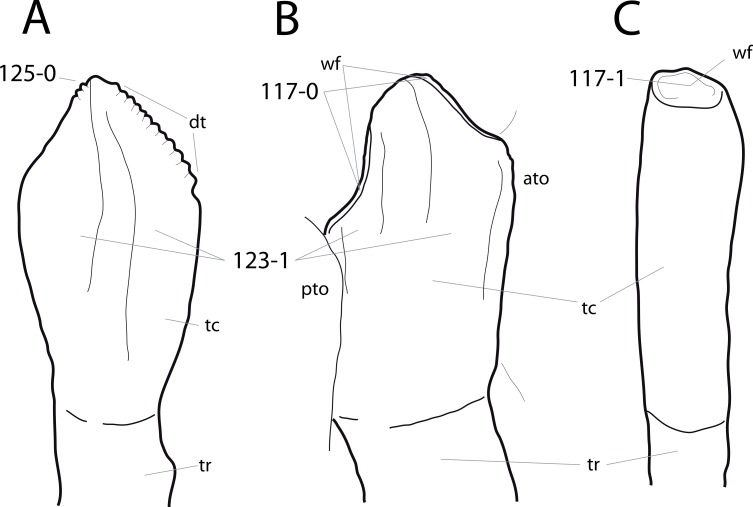
Eusauropod teeth.Tooth of Omeisaurus tianfuensis ZDM T5705 (A; traced from He, Li & Cai, 1988), Camarasaurus sp. SMA 0002 (B), and Diplodocinae indet. CM 3452 (C) in lingual view. Note the V-shaped wear facets in Camarasaurus (B; C117-0), in contrast to the single, planar facet in diplodocids (C; C117-1), the longitudinal grooves in Omeisaurus and Camarasaurus (A, B; C123-1), and the marginal tooth denticles in Omeisaurus (A; C125-0). Abb.: ato, anterior tooth; dt, denticles; pto, posterior tooth; tc, tooth crown; tr, tooth root; wf, wear facet. Teeth scaled to the same crown length.